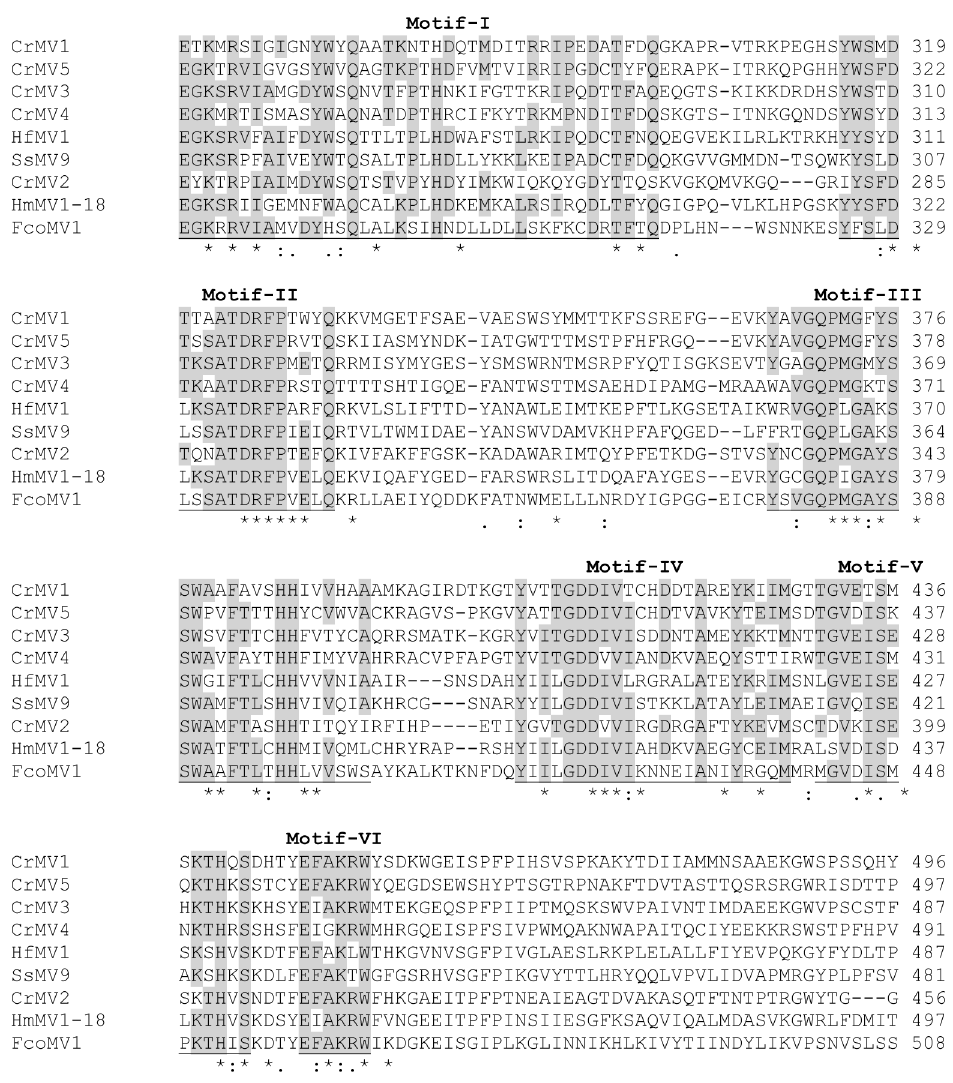
Fig 1. Sequence alignment analysis of the putative RNA-dependent RNA polymerases (RdRp) of Cronartium ribicola mitoviruses (CrMV1 to CrMV5). Six conserved RdRp motifs (I to VI) among Cri-MVs are labelled according to previous report (Hong et al. 1999). Alignment analysis was performed using CLUSTAL program, and it included four other mitovirus species: FcoMV1 (BAQ36630), HfMV1 (AIU44705), HmMV1-18 (BAD72871), and SsMV1 (YP_009121785). Symbols ( * ), (:), and (.) below the sequences are used to indicate identical amino acids, or residues with chemical-similarities at higher and lower levels